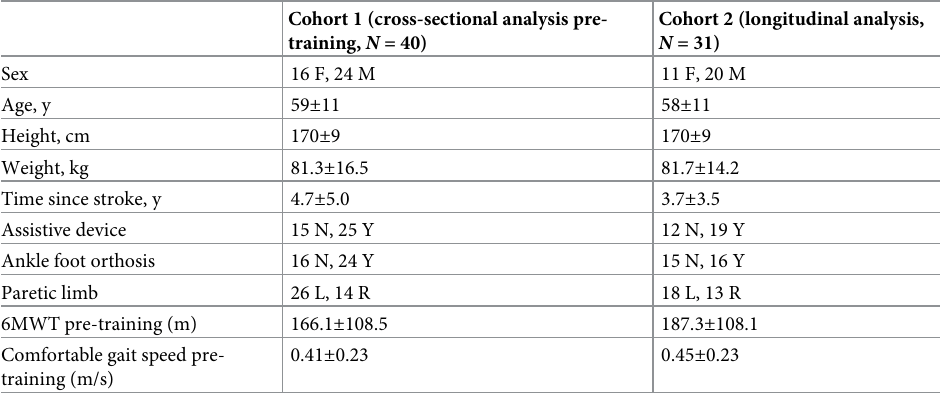
Table 1. Subject demographics.